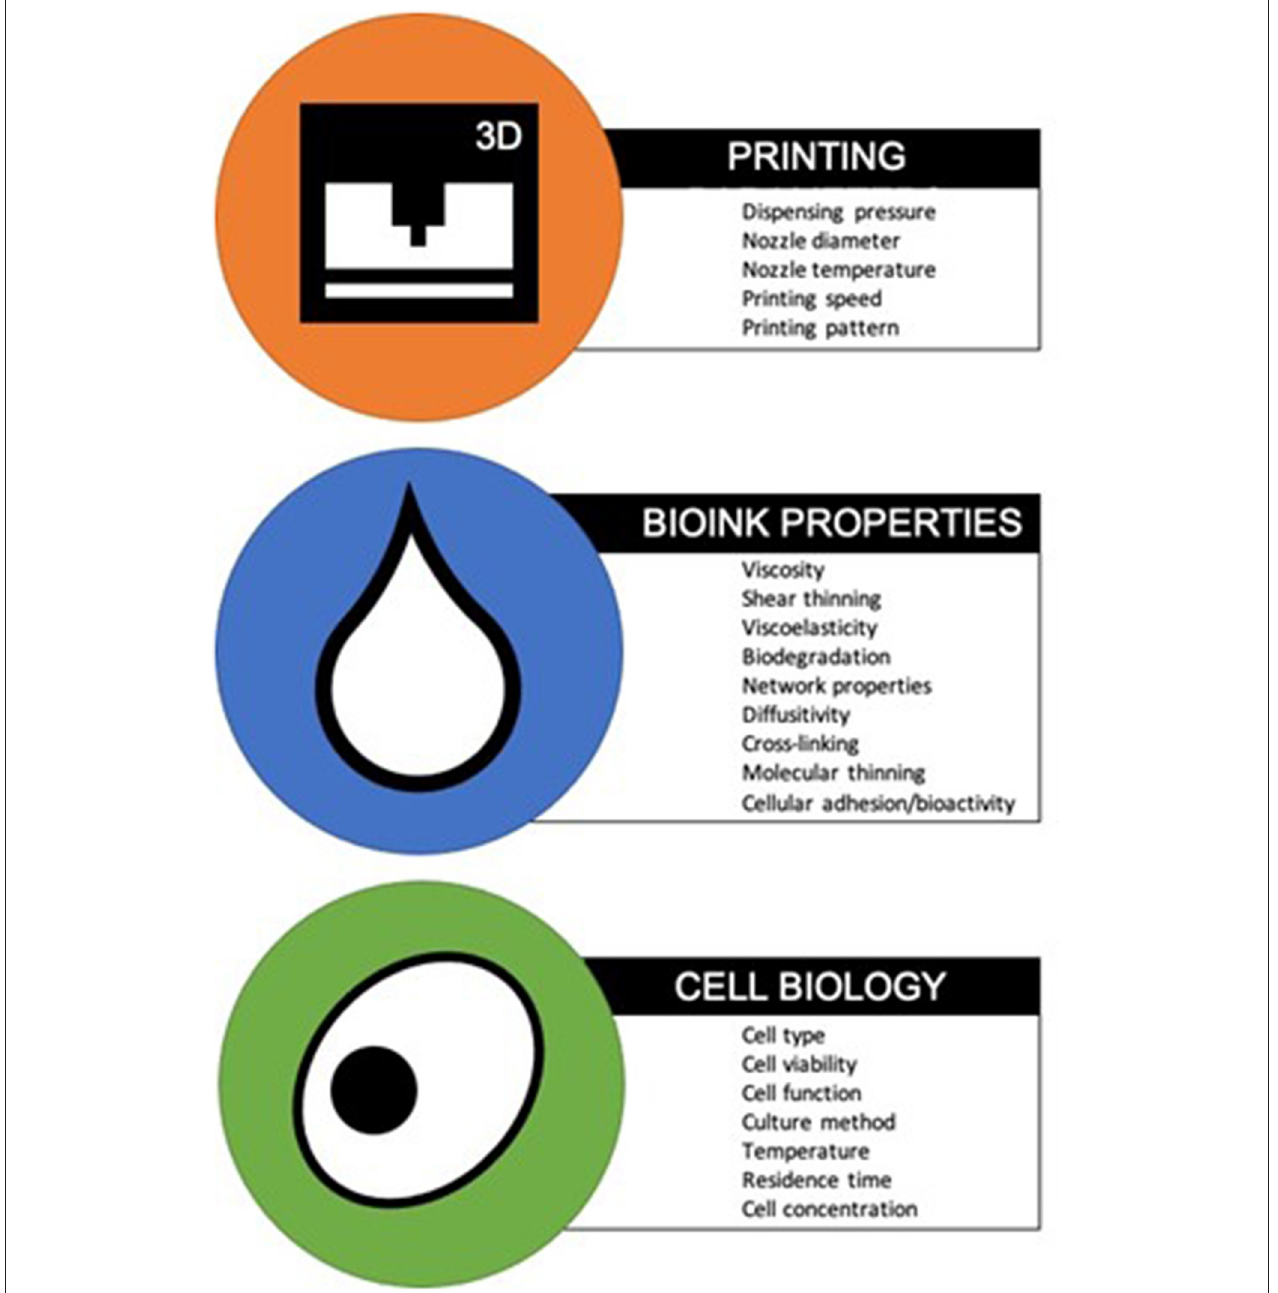
FIGURE 1 | 3D printer parameters, bioink properties, and cell characteristics for optimum bio-printability (Chang et al., 2008; Derby, 2012; Zhang and Cui, 2012; Kirchmajer et al.,